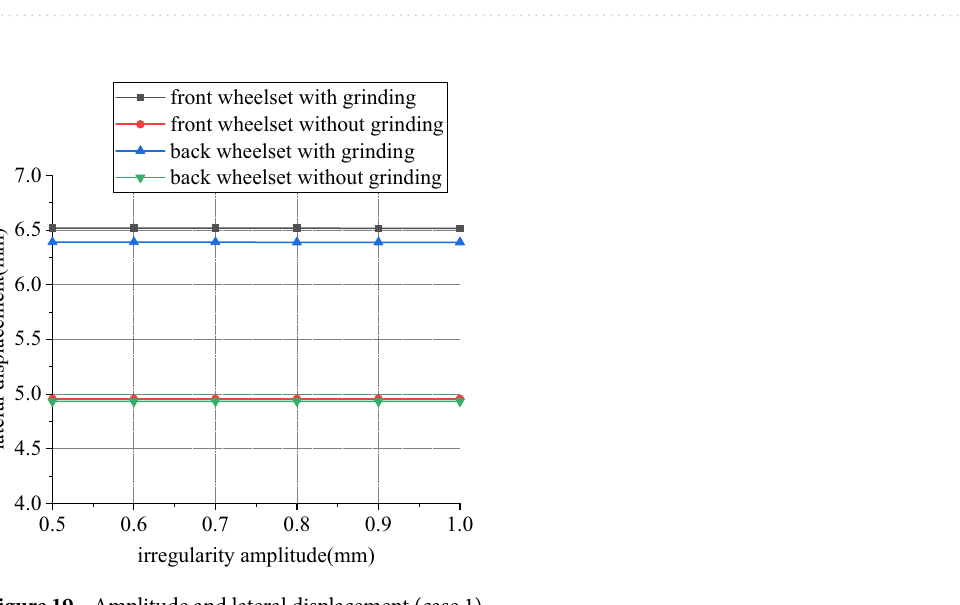
Figure 18. Amplitude and grinding power (case 1).